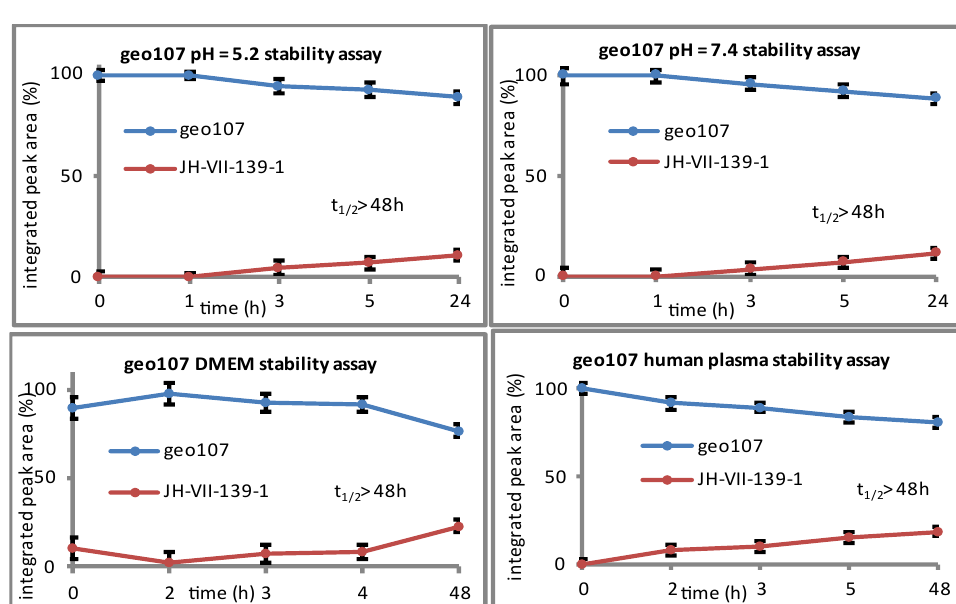
Figure 5. Chemostability of conjugate geo85 .